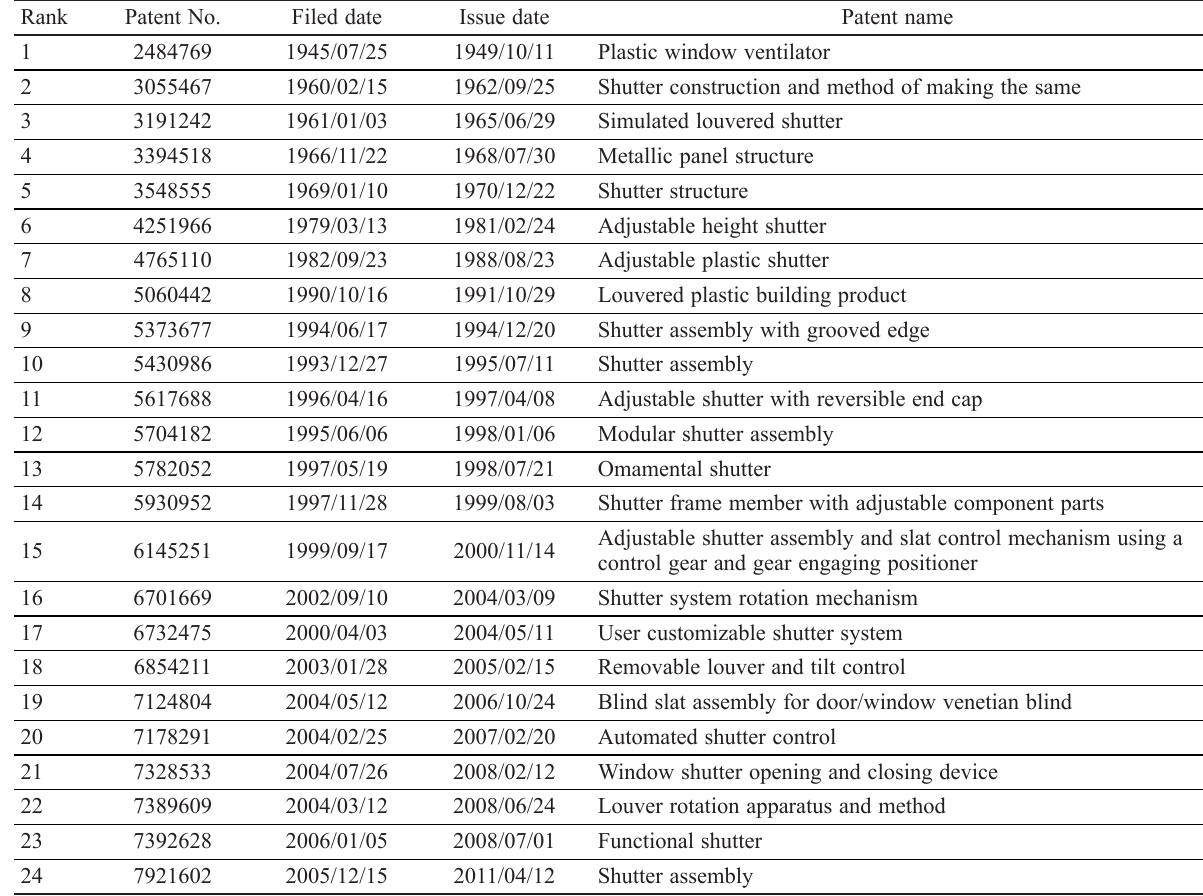
Table 8. Main path for 24 most often cited patents in the technology field Rank Patent No.